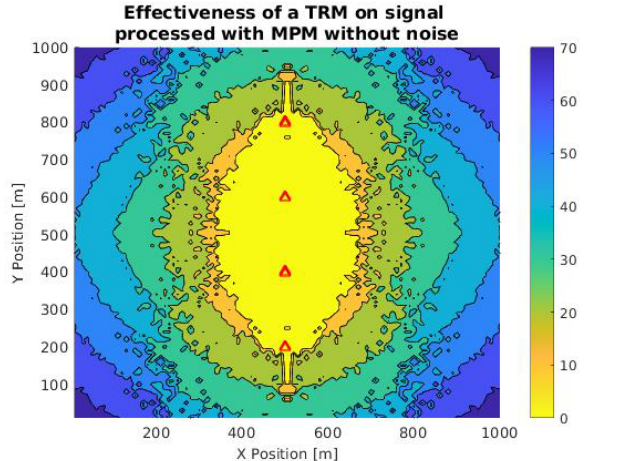
Figure 9. Contour plot of the accuracy in the TRM array in an area of 1 km 2 to a bulk carrier signal previously treated with MPM ( M = 860). Red triangles are the positions of the sensor and the color scale is a function of the difference between the expected and calculated location.